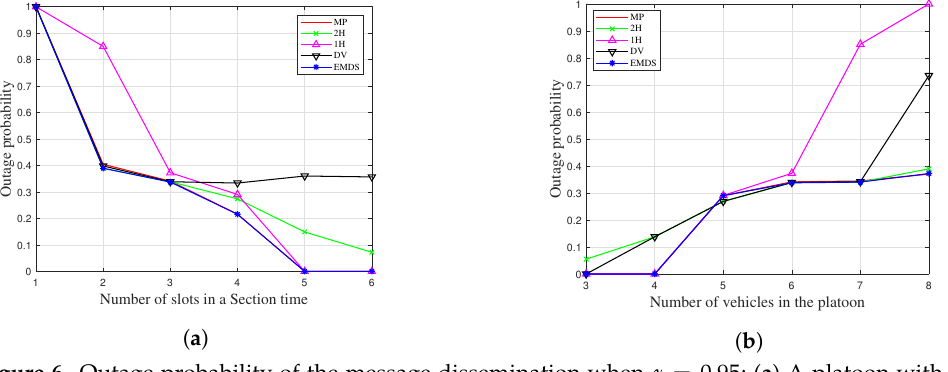
Figure 6. Outage probability of the message dissemination when α = 0.95; ( a ) A platoon with six vehicles varying the number of slots ( M ) in a section time and ( b ) Three slots in a section time varying the number of vehicles ( N ) in the